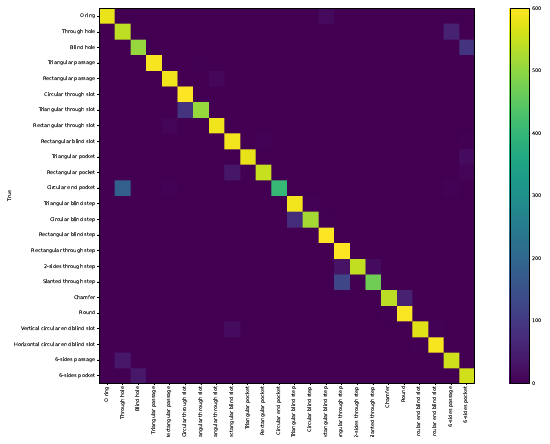
Figure A6. Confusion matrix for [38].